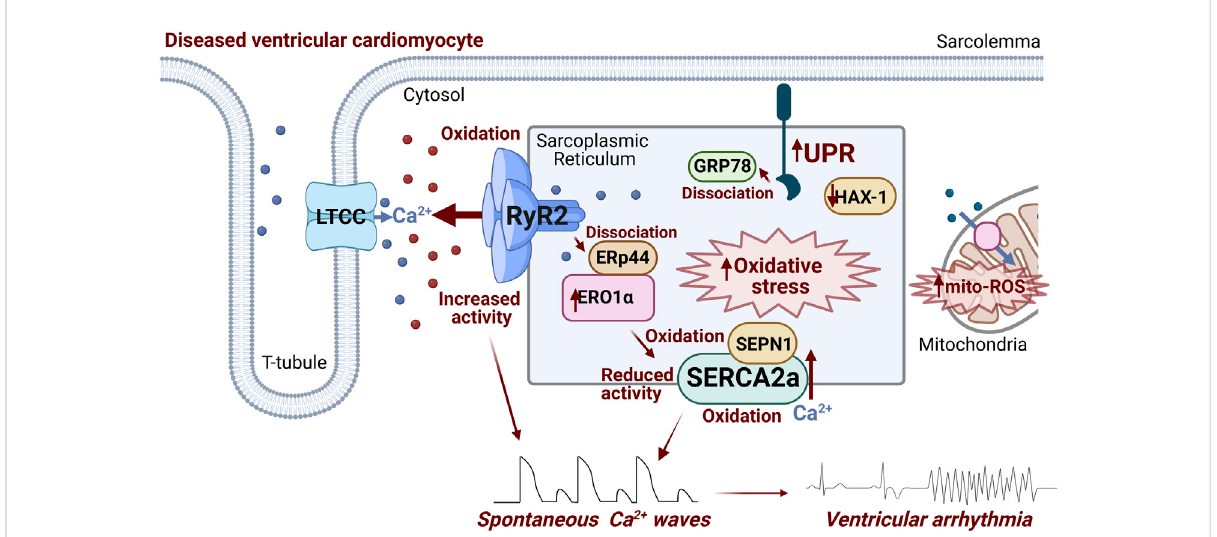
FIGURE 2 Schematic summarizing ER stress-associated modulation of RyR2 and SERCA2a occurring in diseased ventricular cardiomyocytes that contributes to arrhythmogenesis. Activation of ER stress and the UPR increases ERO1 α expression/activity, promoting generation of ROS. ERO1 α dissociates ERp44 from the RyR2 complex, increasing channel activity. Additionally, intra-SR oxidative stress promotes RyR2 oxidation at cytosolic face of the channel, exacerbating its hyperactivity. Putative oxidation of two intraluminal SERCA2a cysteines and Cysteine 674 at cytosolic face decreasestheactivityoftransporter.SEPN1servesasaredoxsensorofSERCA2a,withlowlevelsofluminalCa 2+ activatingtheproteinasareductase, and mitigating increased oxidation levels. Downregulation of HAX-1 in diseased hearts leads to less inhibition of the UPR by the protein, driving downstream SERCA2a oxidation and protein degradation. Image created with